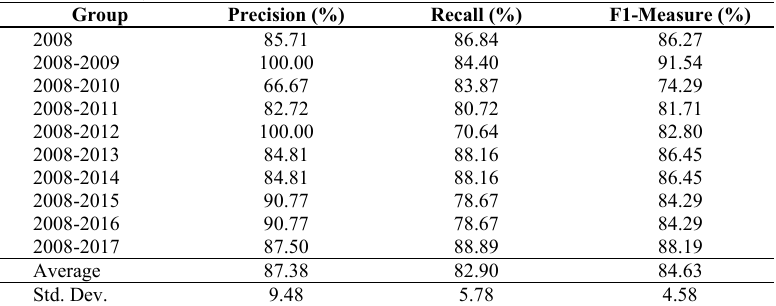
TABLE 11 P RECISION , R ECALL AND F1-M EASURE FOR M ERIT -B ASED A DMISSION S TUDENTS